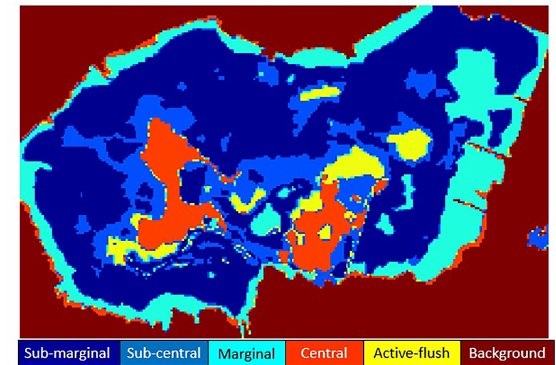
Figure 5. Ground truth with 5 ecotopes. Table 1. Accuracies for all the cases.